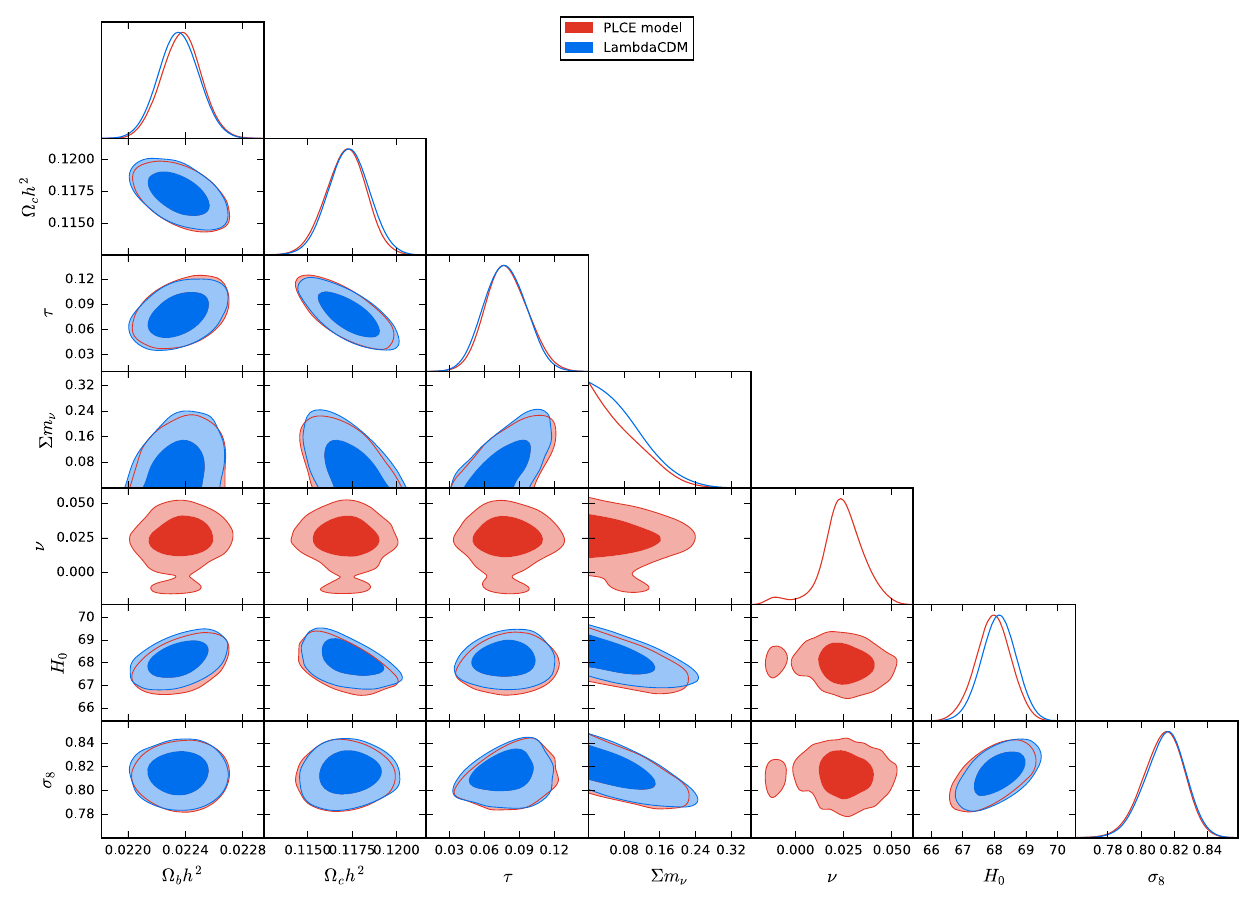
(cid:11) Fig. 11 One and two-dimensional distributions of (cid:4) b h 2 , (cid:4) c h 2 , m ν , ν , H 0 , and σ 8 in the PLCE and (cid:2) CDM models, where the contour lines represent 68% and 95% C.L., respectively Table 3 Fitting results for the PLCE and (cid:2) CDM models, where the limits are given at 68% and 95% C.L., respectively Parameter PLCE (68% C.L.) PLCE (95% C.L.) (cid:2) CDM (68% C.L.) (cid:2) CDM (95%